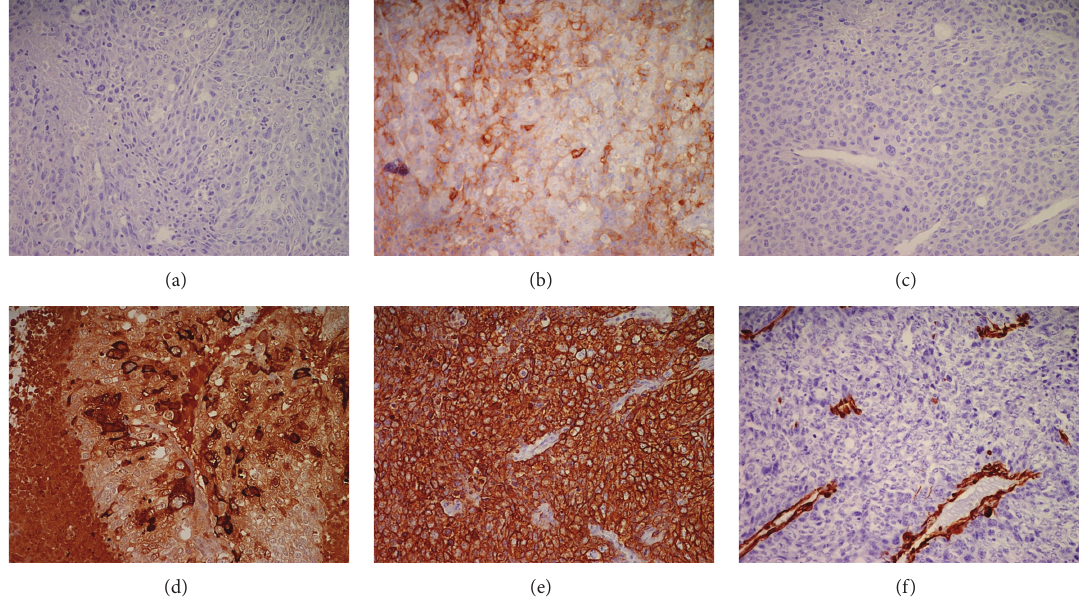
Figure 3: Immunohistochemistry from lung metastasis revealing choriocarcinoma with the tumor staining AFP negative (a), PLAP positive (b), CD30 negative (c), HCG positive (d), MAK 6 positive (e), and vimentin negative